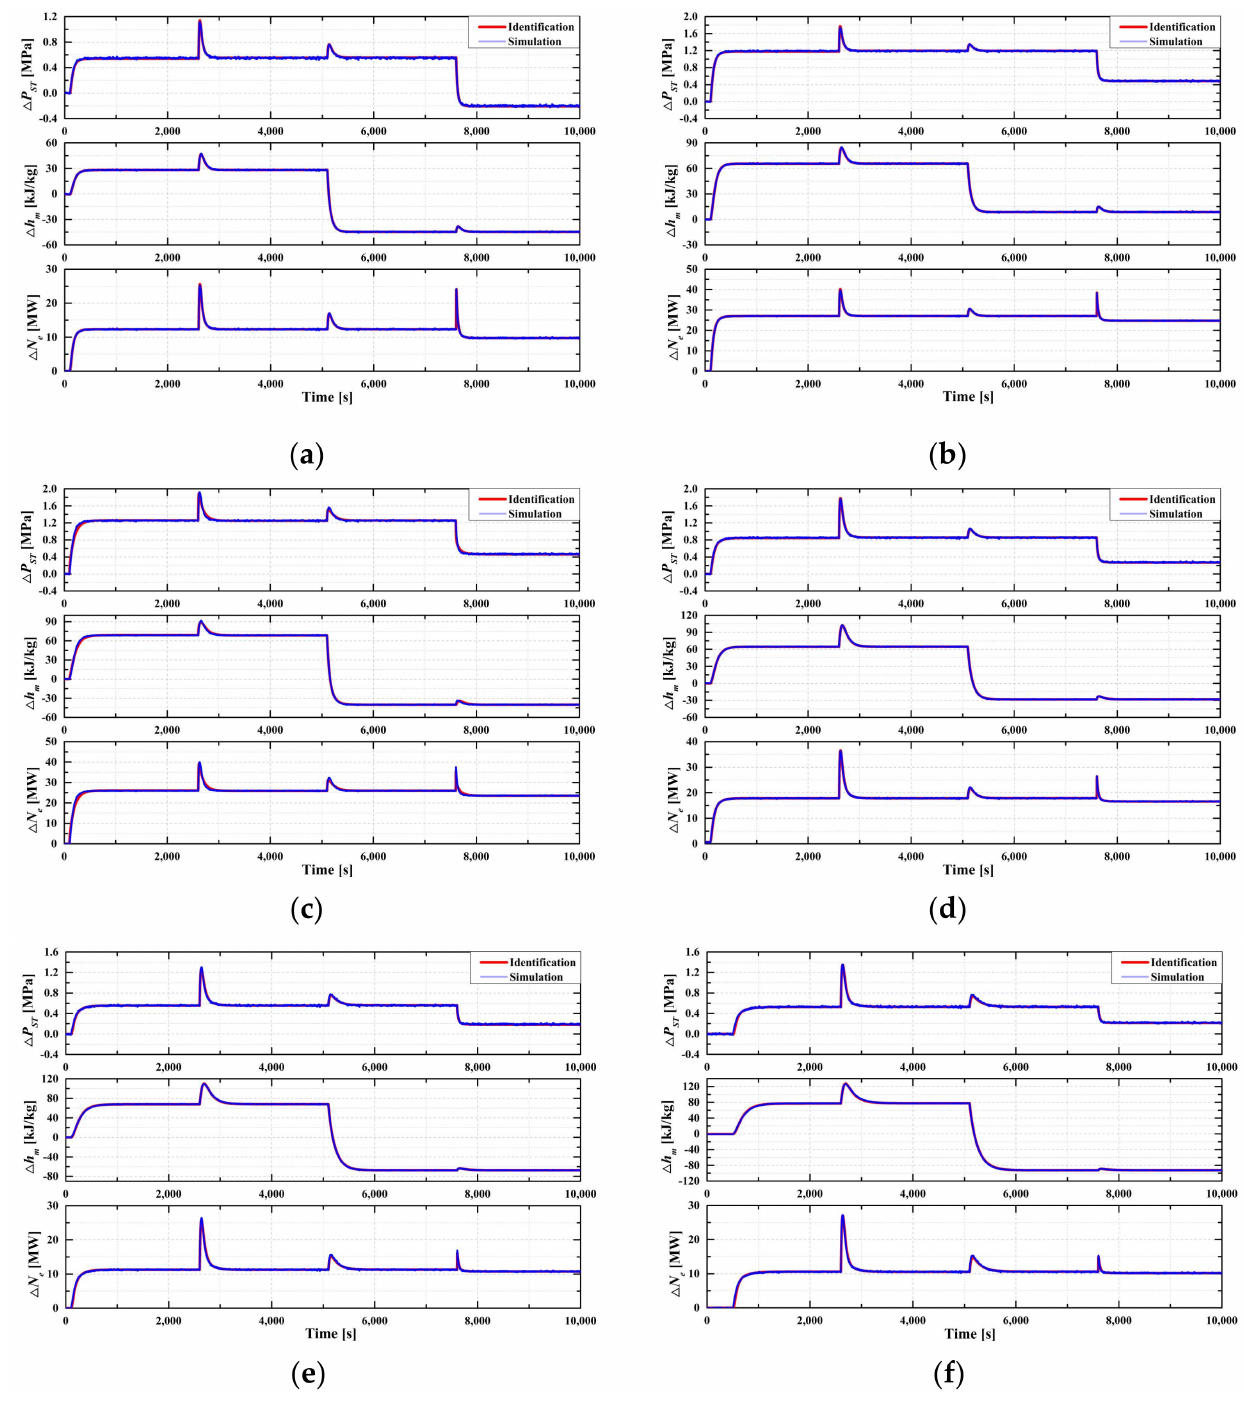
Figure 6. Identification results with step excitation signal. ( a ) BMCR; ( b ) BECR; ( c ) THA100%; ( d ) THA75%; ( e ) THA50%; ( f )